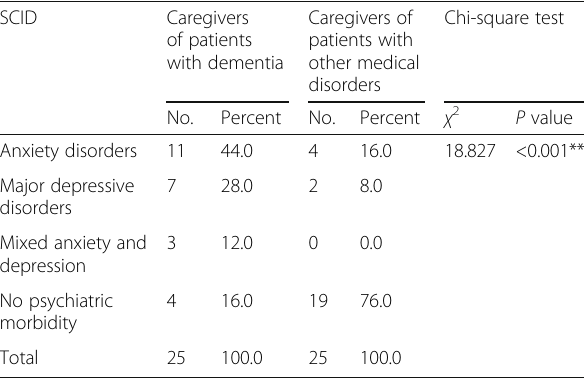
Table 3 Psychiatric morbidity in caregivers of demented and non-demented